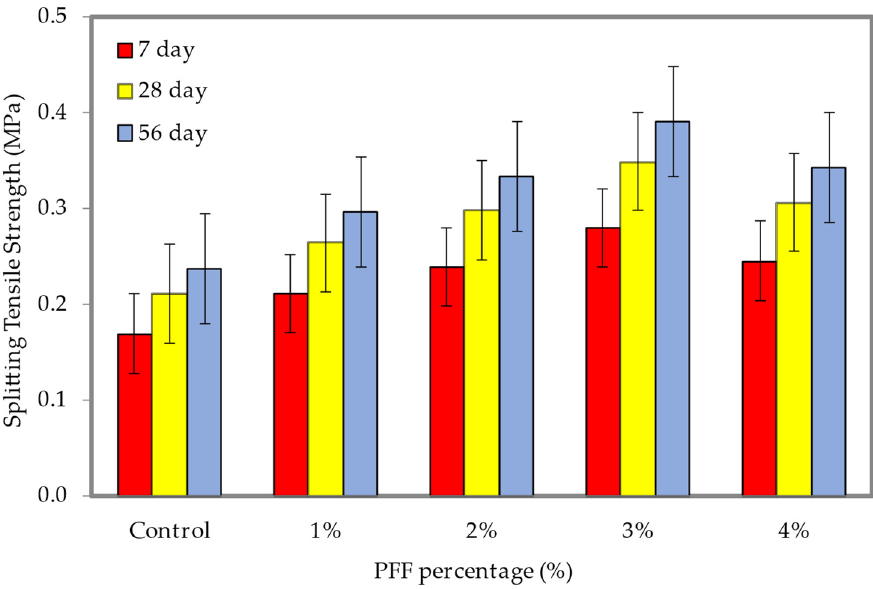
Figure 18. Splitting tensile strength of foamed concrete of 600 kg/m 3 density with varying PFF percentages.